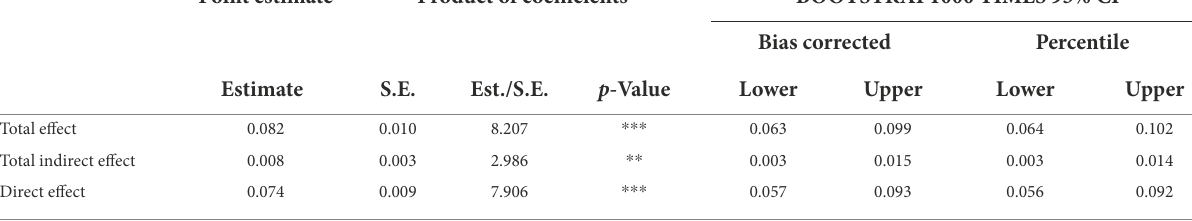
TABLE 4 Analysis and comparison of specific direct and indirect effects.